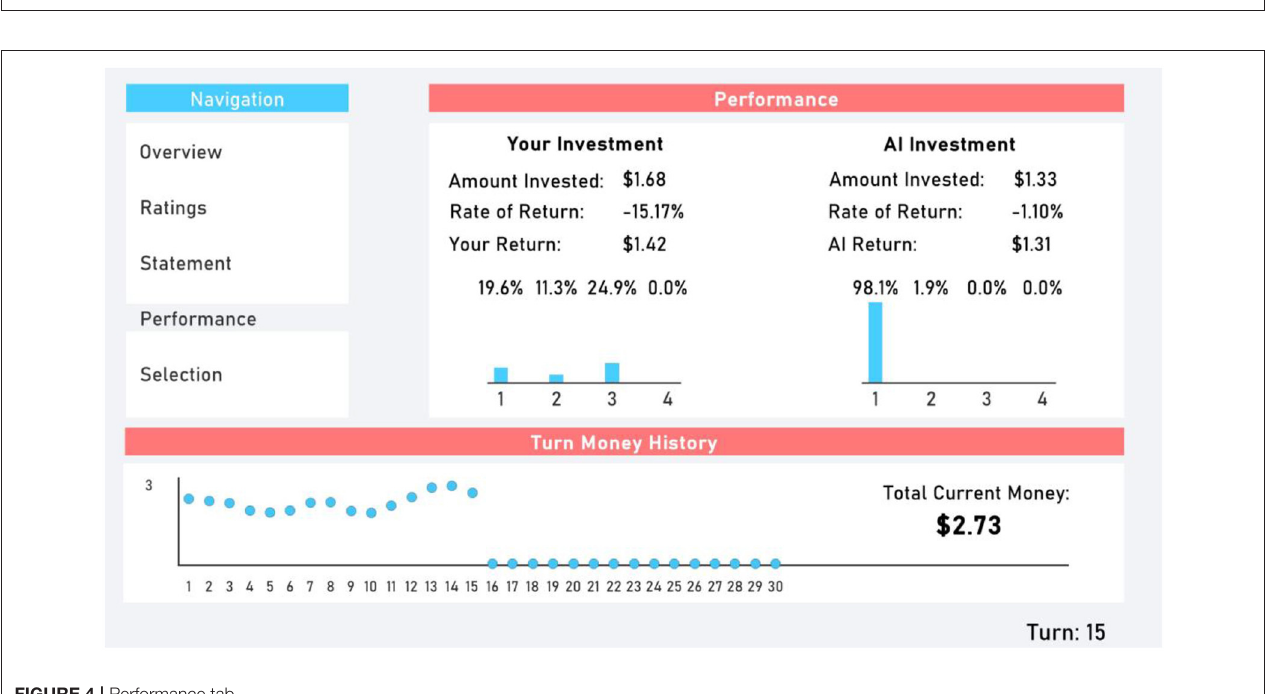
FIGURE 4 | Performance